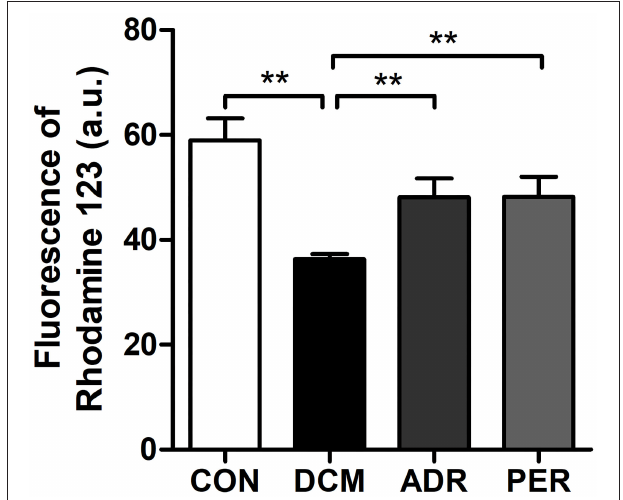
FIGURE 5 | Effects of ADR on the fluorescence of Rhodamine 123 in DCM rats. Compared to DCM group, the fluorescence of Rhodamine 123 increased in ADR and PER group. CON, control; DCM, diabetic cardiomyopathy; ADR, adropin; PER, perindopril. Values are expressed as mean ± standard deviation. * P < 0.05, ** P <